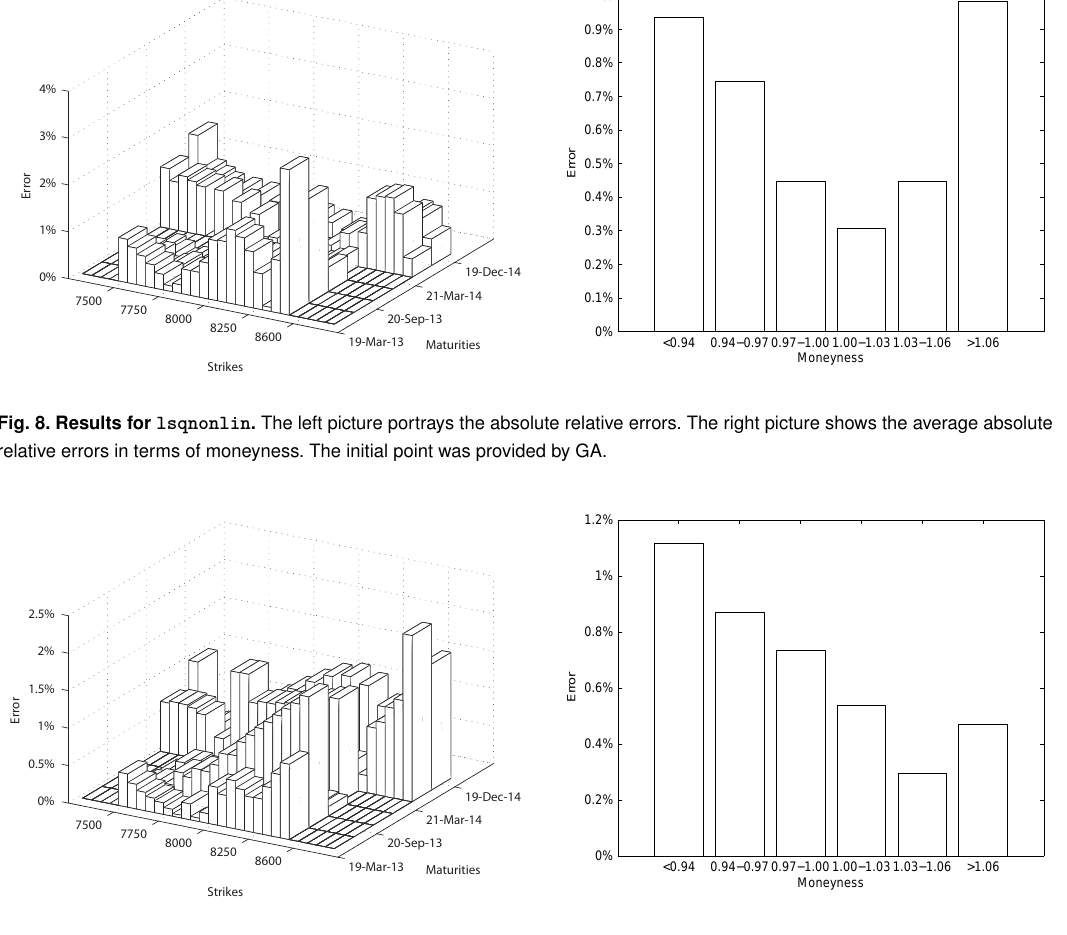
Fig. 7. Results for lsqnonlin . The left picture portrays the absolute relative errors. The right picture shows the average absolute relative errors in terms of moneyness. Initial values were provided by deterministic grid.